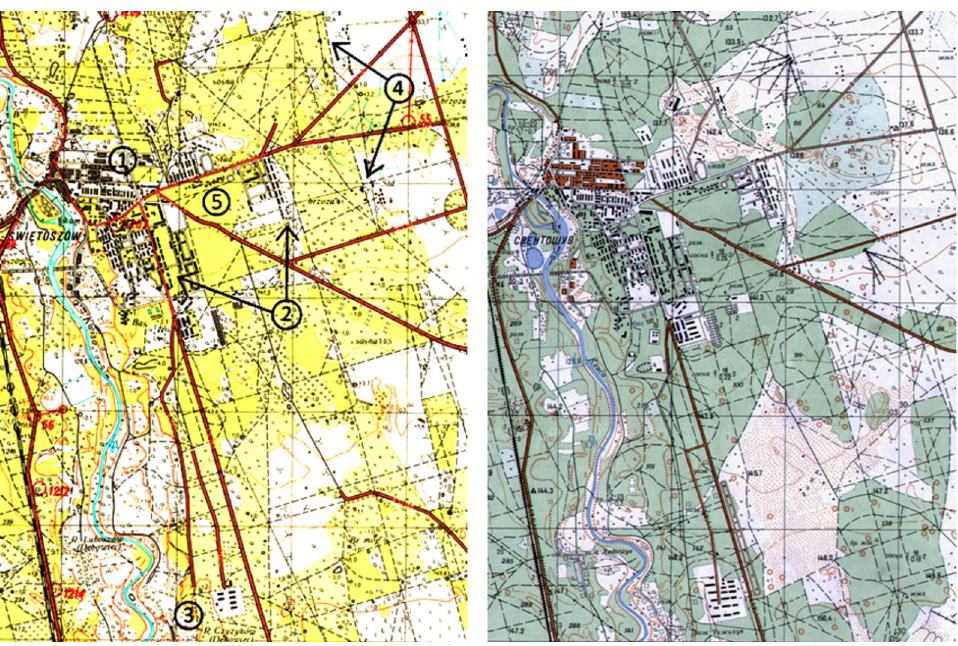
Fig. 2. Parts of maps at the scale of 1:25,000 of the Świętoszów garrison (sheet M-33-19-D-d): on the left − the Polish map, 1956, on the right − the Soviet